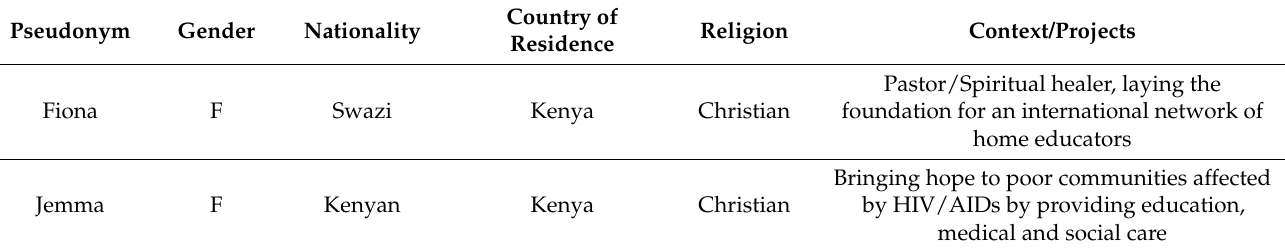
Table 2. Participant